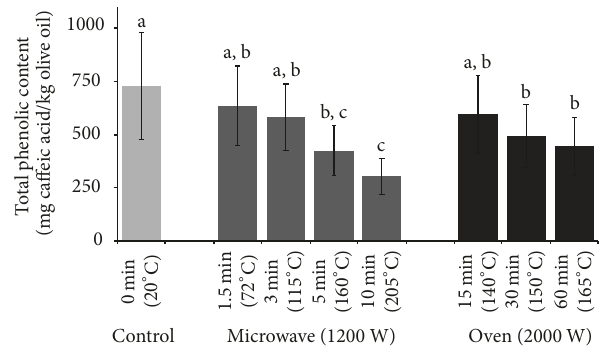
Figure2:Totalphenoliccontents(meanvalue ± standarddeviation) of olive oils according to the cooking process applied: control (no heat-induced, 20 ∘ C); microwave heating (from 1.5 to 10 min, corresponding to 72 to 205 ∘ C); and electrical conventional oven (15 to 60 min, leading to 140 to 165 ∘ C). Different small letters mean statistical significant differences, at a 5% significance